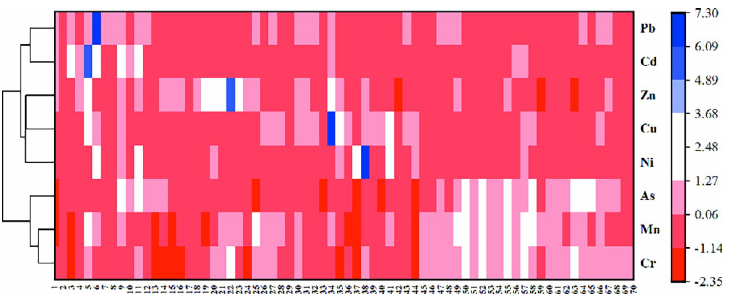
Fig 6. Cluster analysis heat map based on ward